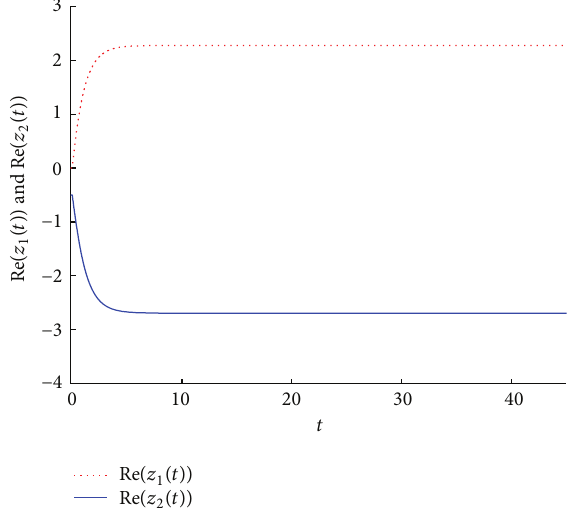
Figure 1: State trajectories of neural network (38).